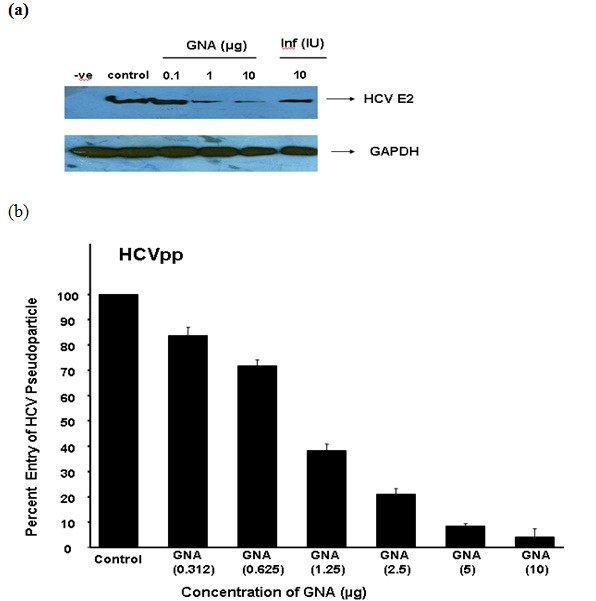
Antiviral effect of GNA against HCVpp in liver cells. HCVpp was produced in HEK 293 T cells and collected in media after filtration in 0.45 micron filter. (a) GNA was incubated with HCV pseudo particle at 37°C for 1 hr. After 1 hrs Huh-7 cells were infected with pseudo particle of HCV 3a genotype in the presence and absence of GNA per well and incubated for additional 48 hrs. At the end of incubation period protein were isolated and analyzed by western blotting with anti E2 monoclonal antibody and GAPDH serve as internal control. (b) GNA was incubated with HCV pseudo particle at 37°C for 1 h. After 1 h Huh-7 cells were infected with pseudo particle of HCV 3a genotype in the presence and absence of different concentrations of GNA and incubated for 3 hrs. After 24 h cells were lysed and luciferase activity was determined by using a luminometer. Luciferase activity is not reported as an absolute value, but is calculated relative to the 'no drug' condition and reported on the y-axis as a percentage. Results are represented as the average and standard error for three independent experiments. P value > 0.05 vs control was considered as statistically significant.